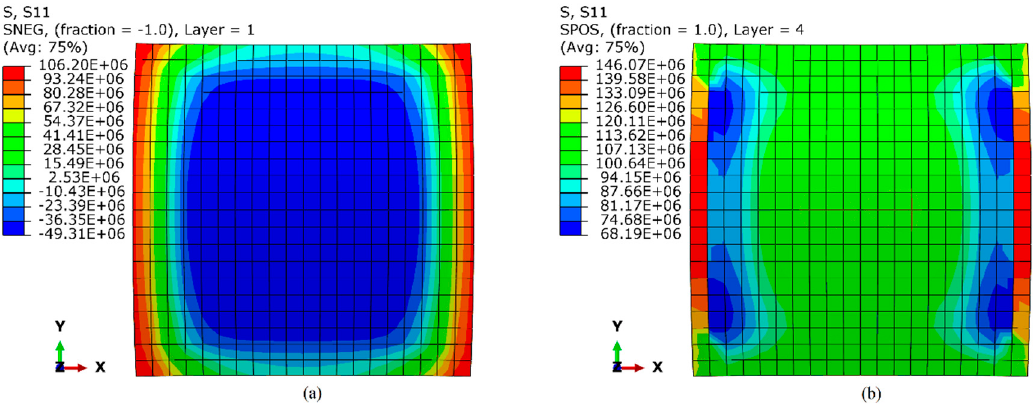
Figure 6. Axial stress distribution in SMAC—( a ) 0° fiber-oriented bottom layer; ( b ) 90° fiber-oriented top layer.